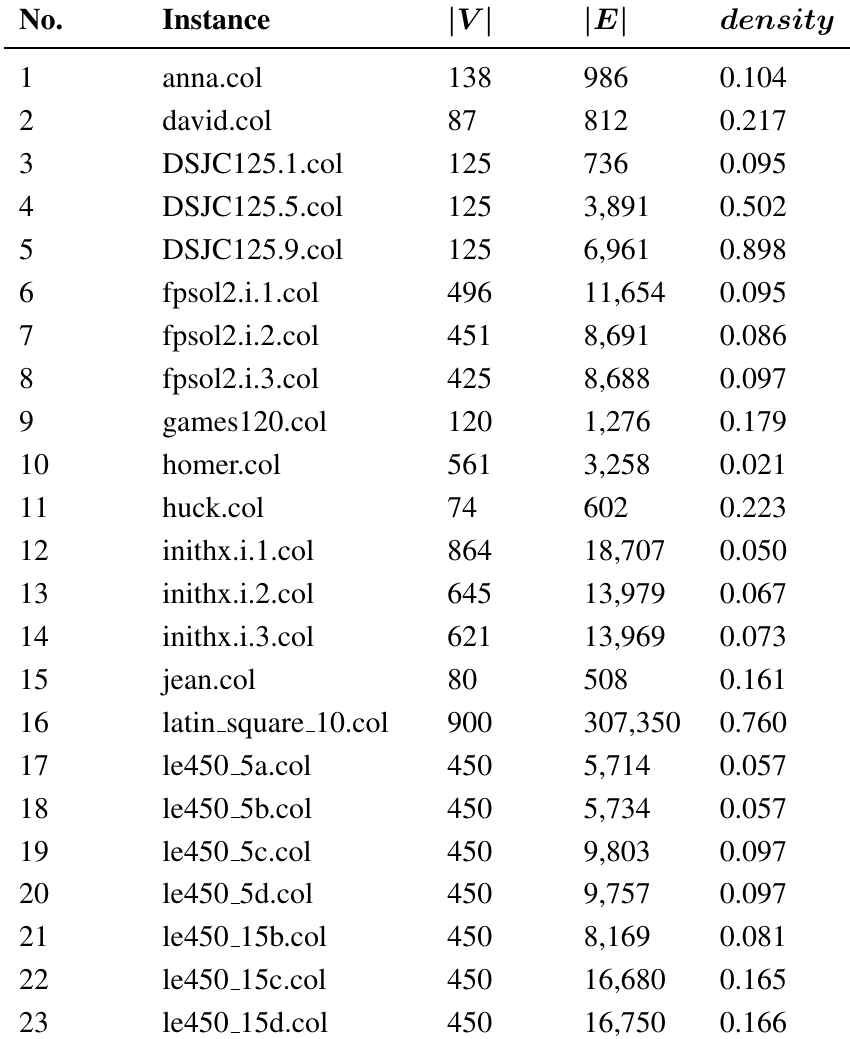
Table 1. Benchmark instances and their